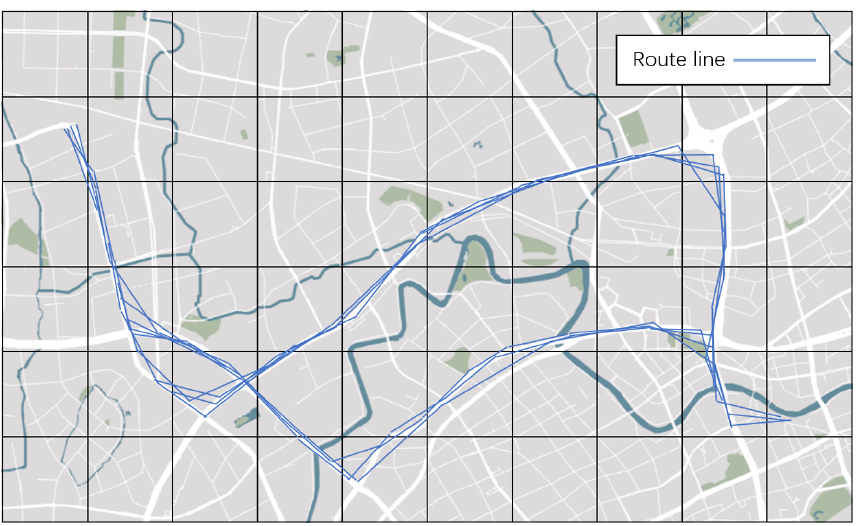
Figure 6. Historical roadmap (raw).